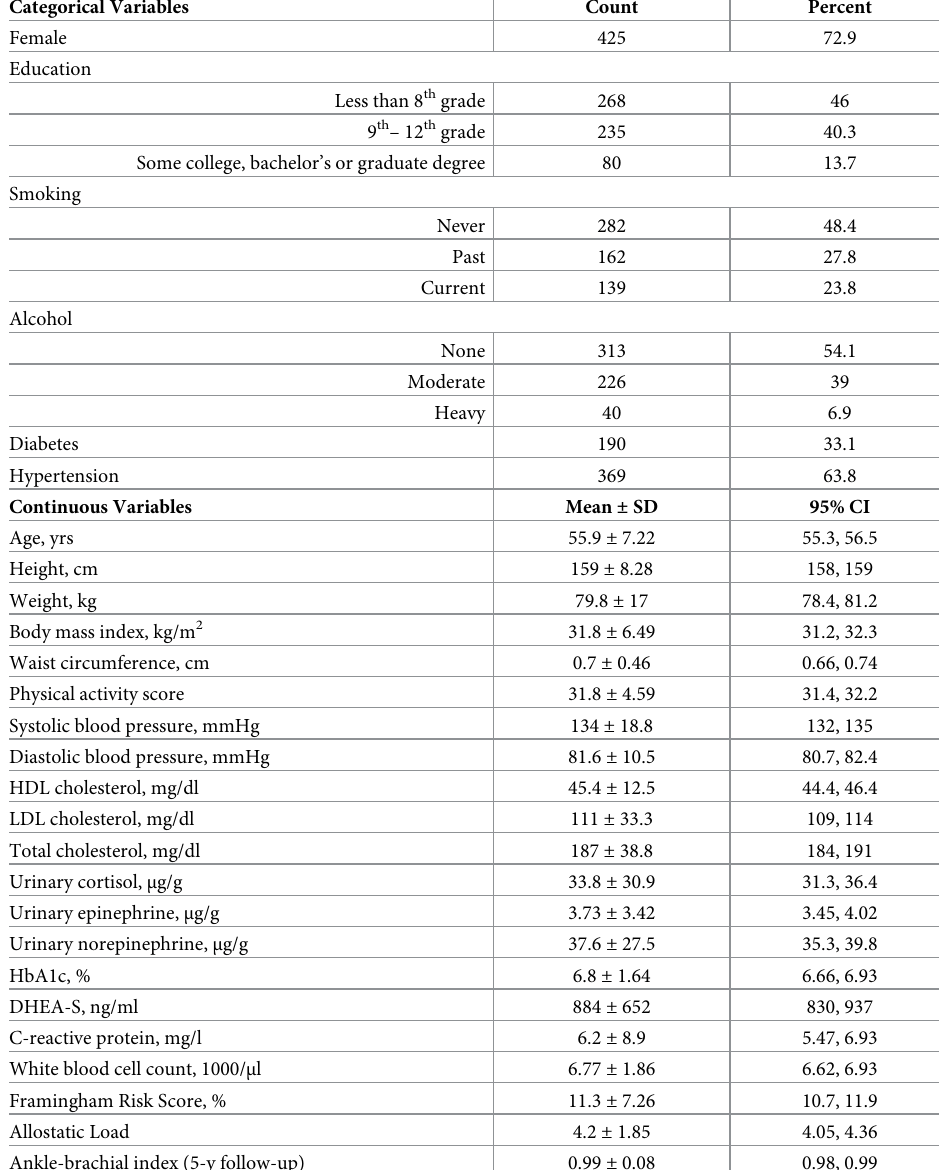
Table 1. Participant demographics at baseline ( n = 583). Categorical Variables